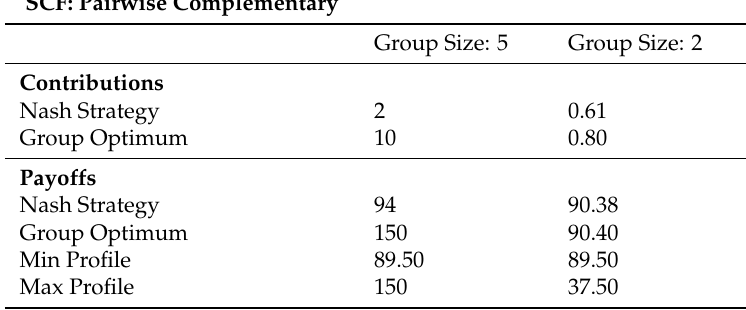
Table 5. Experimental design in the complementary SCF production treatment: group size, equilibria and payoffs. SCF: Pairwise Complementary Group Size: 5 Group Size: